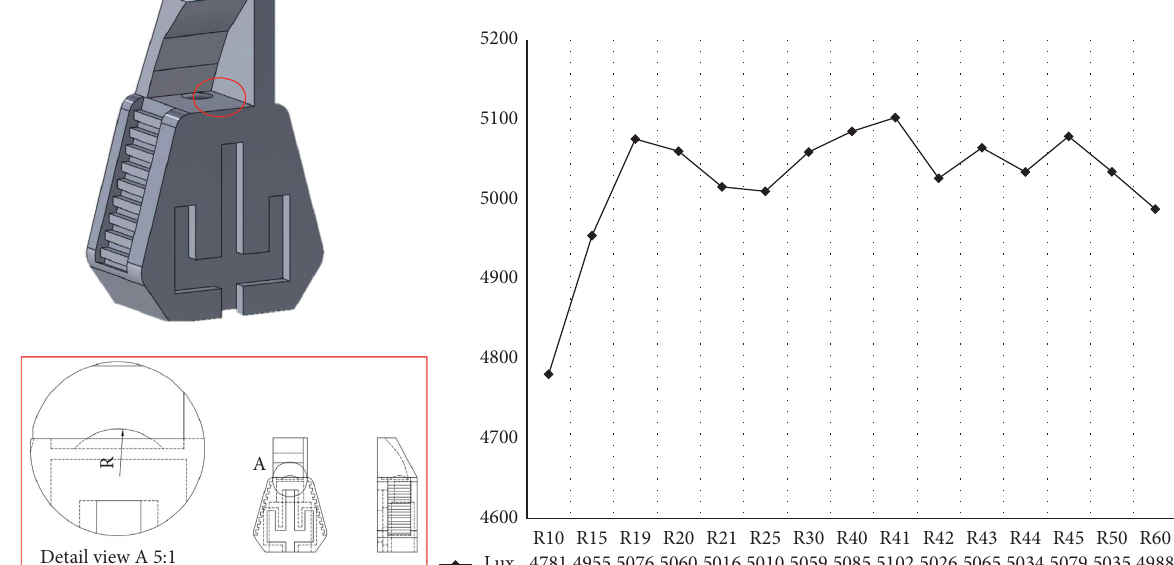
Figure 12: Simulation results of lens curvature radius design.